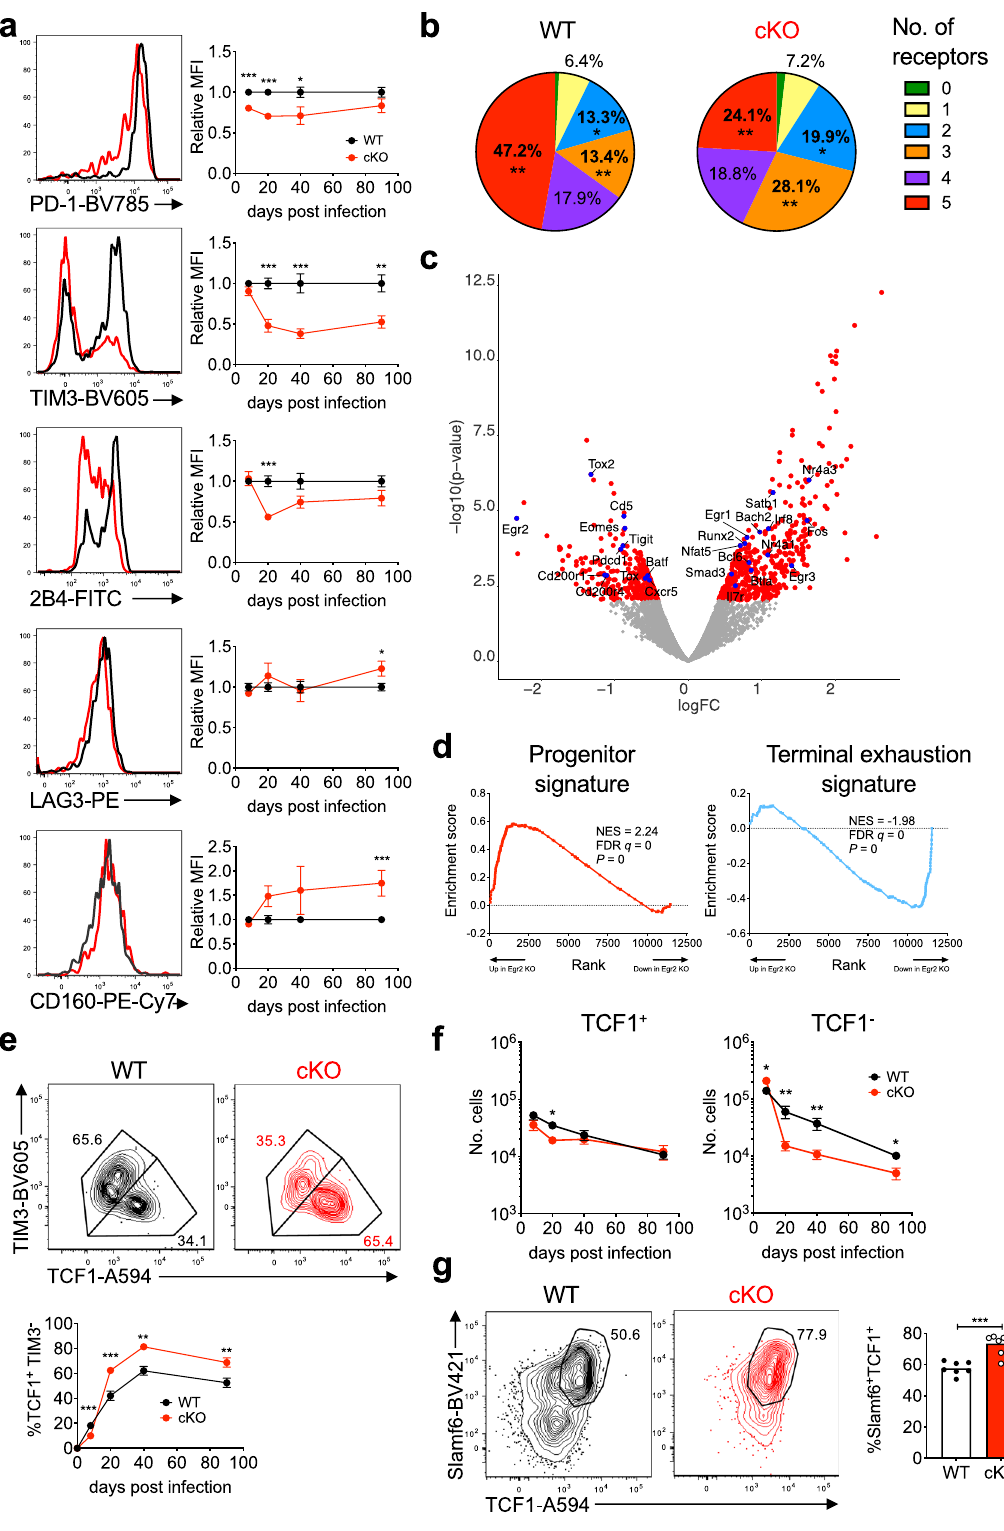
is a key mediator of the response to therapy 9,11,13,15,17,18 . We thus tested whether PD-L1 blockade could trigger expansion and differentiation of cKO exhausted cells. Despite having comparable markedly impaired response to PD-L1 blockade. Virus-speci fi c CD8 + T cell expansion was dramatically blunted, and therapy failed to increase the proportion of TCF1 − cells to the levels seen